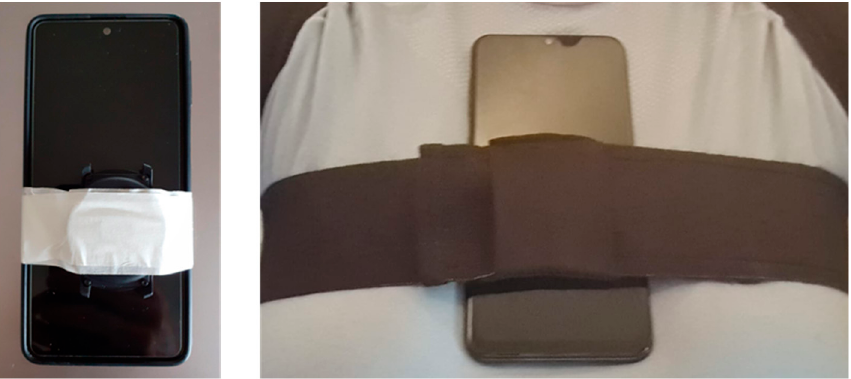
Figure 10. Setup of the reliability test during forward inclination. The SW Mobvoi TicWatch E2 and the smart harness developed together were compared to the gold standard system (smartphone with MATLAB mobile platform).